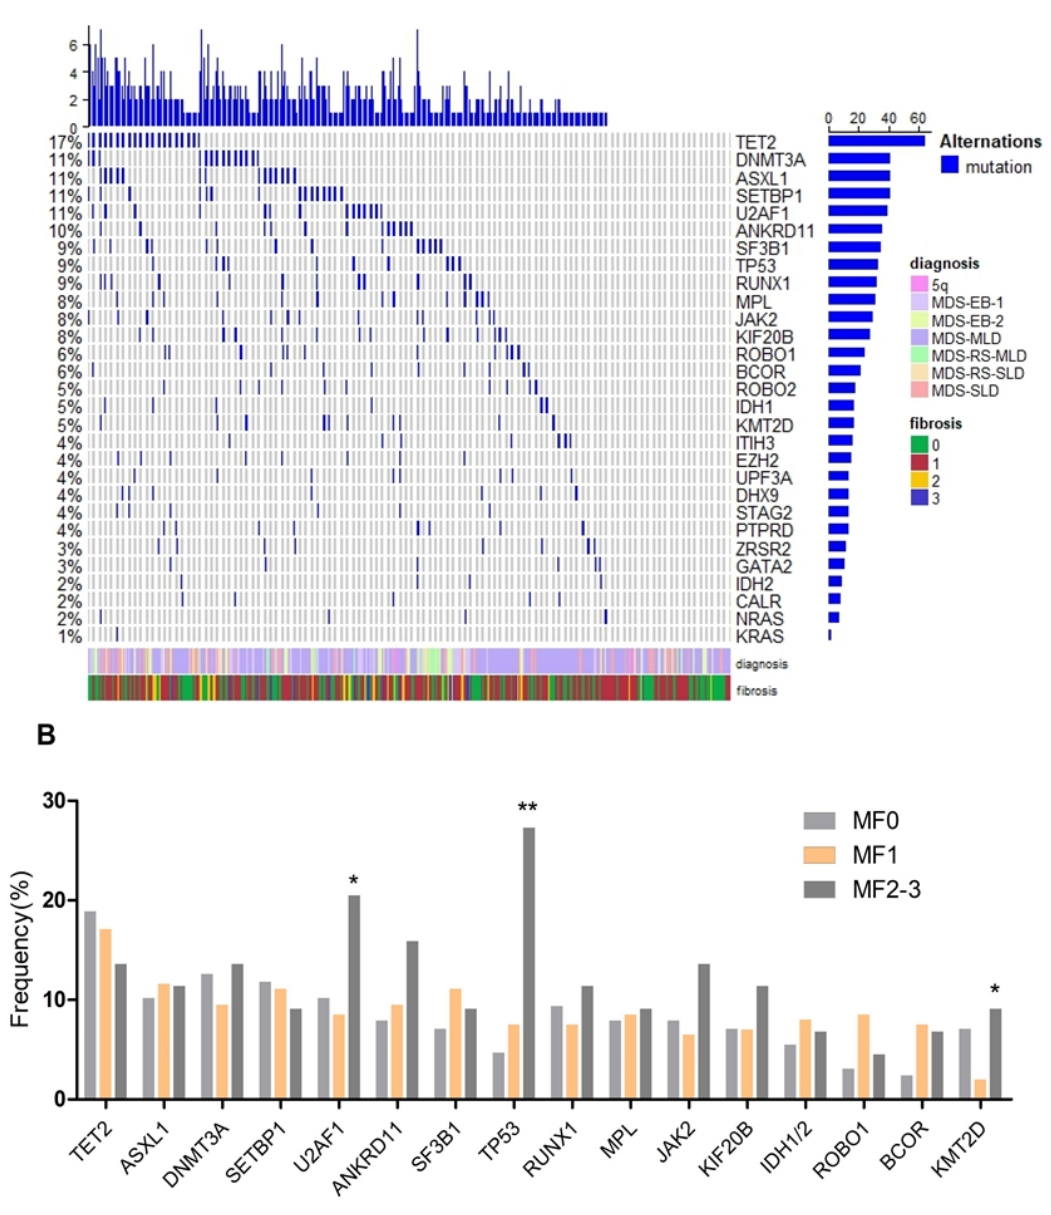
Figure 3. Mutational landscape of MDS in the cohort. ( A ), heat map showing the somatic mutational profile detected on next ‐ generation sequencing; ( B ), frequency of mutations in different fibrosis subtypes, which are shown in indicated colors. *: p < 0.05; **: p < 0.001.